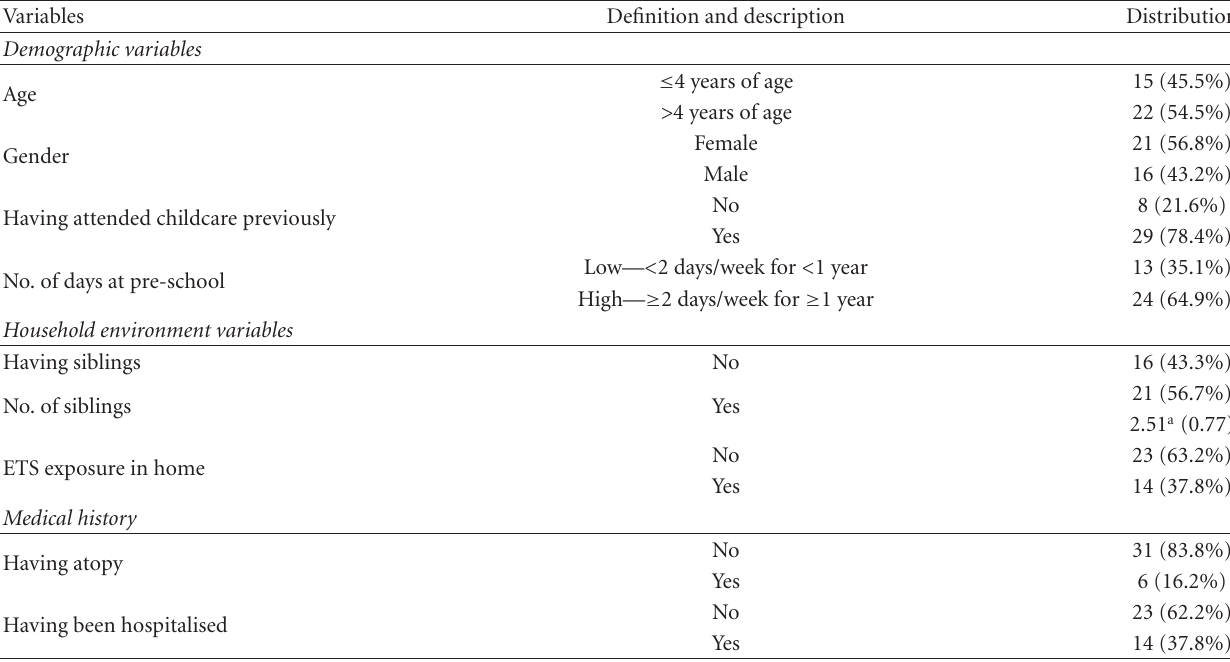
Table 1: Demographic characteristics of the study population ( n =